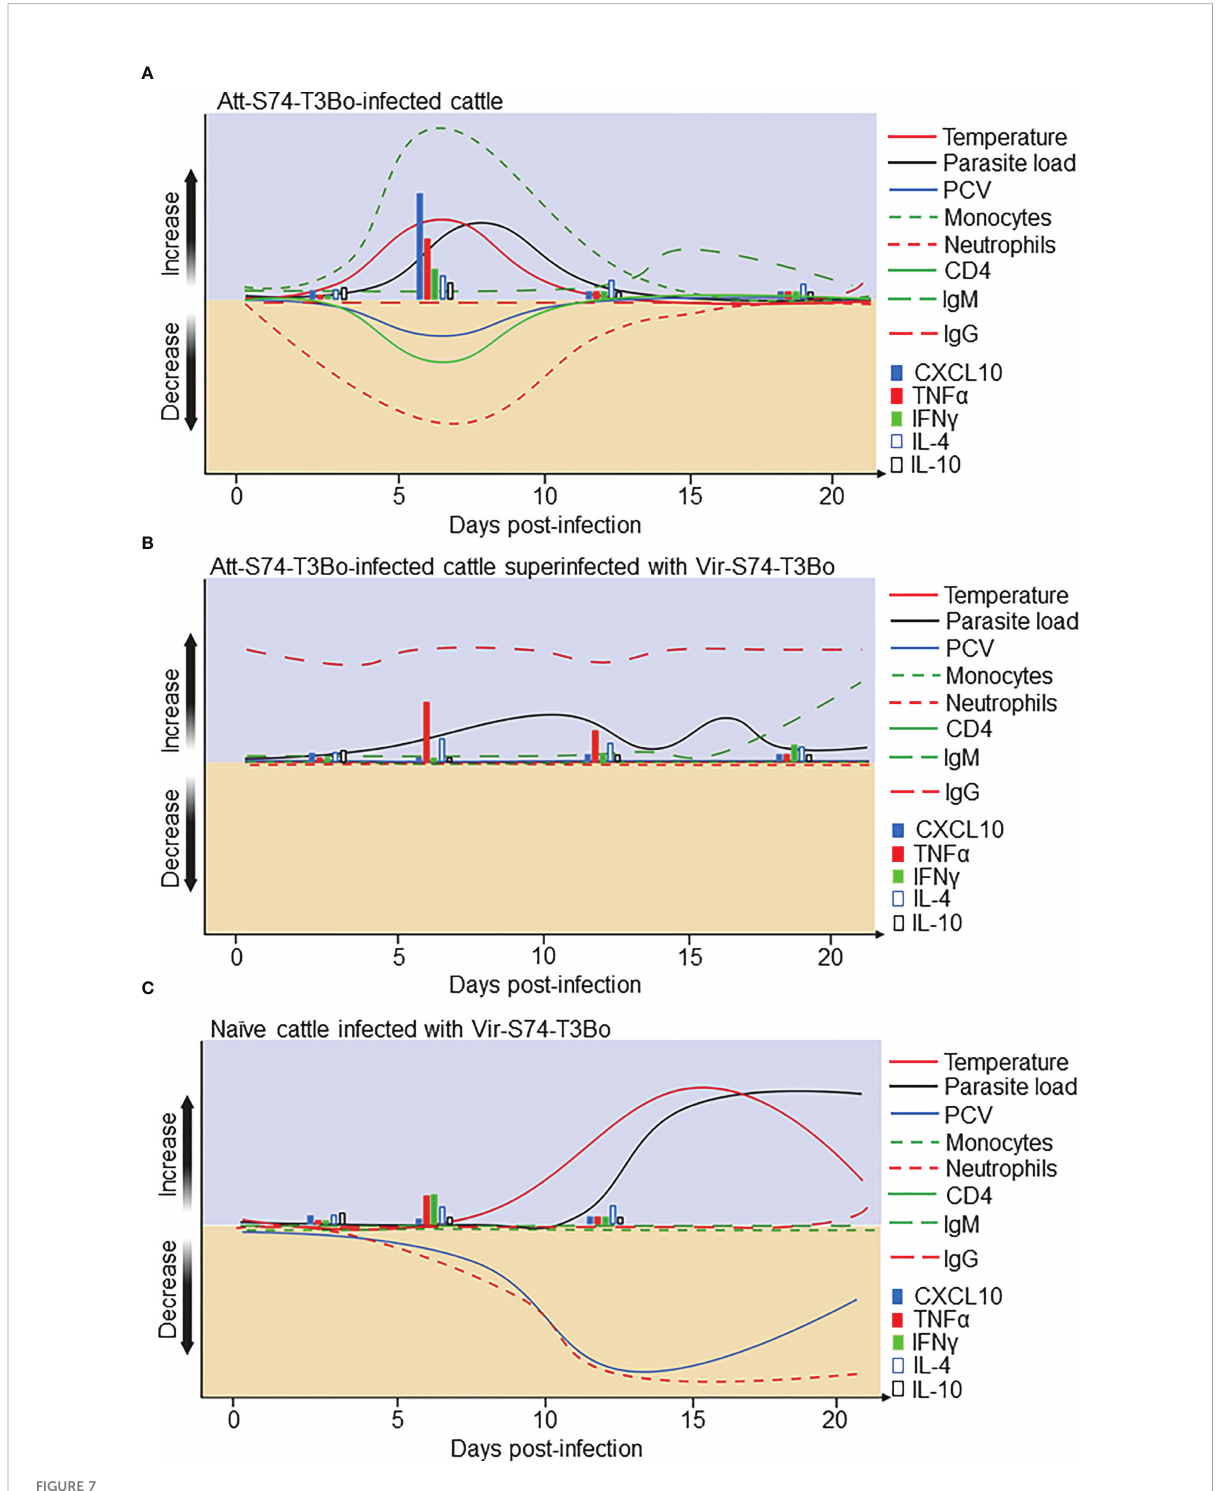
FIGURE 7 Proposed model for the immunological events after infection with the in vitro culture attenuated B . bovis strain Att-S74-T3Bo and superinfection with the virulent B . bovis strain Vir-S74-T3Bo. (A) Att-S74-T3Bo infection in naïve animals. (B) Vir-S74-T3Bo superinfection in Att- S74-T3Bo-protected. (C) Vir-S74-T3Bo infection in naïve